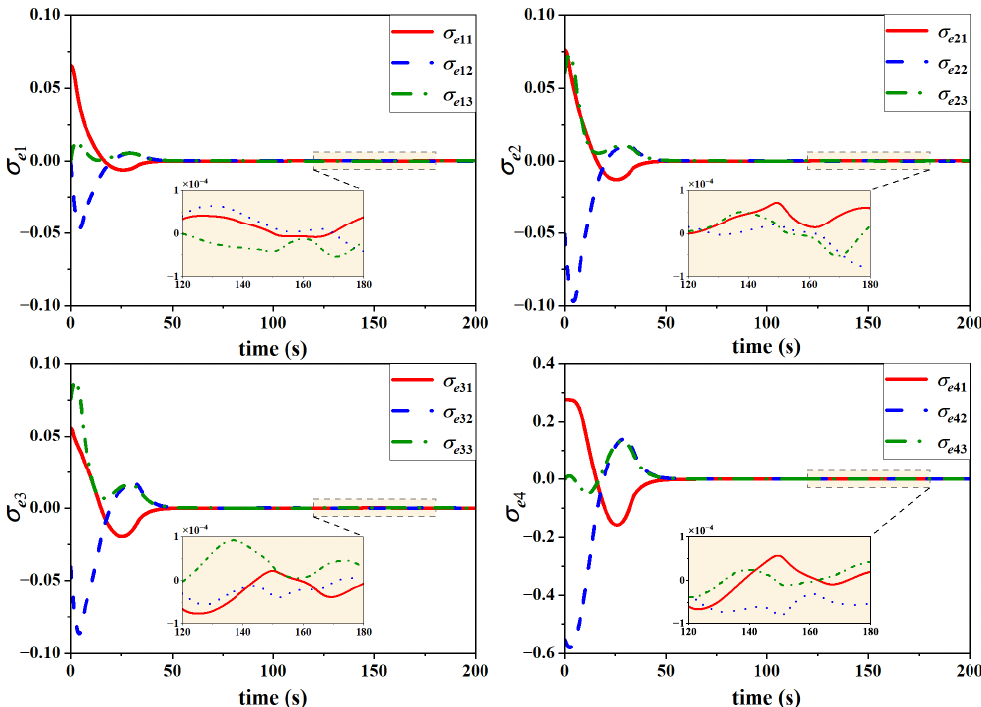
Figure 3. Attitude tracking error trajectories of four spacecraft.